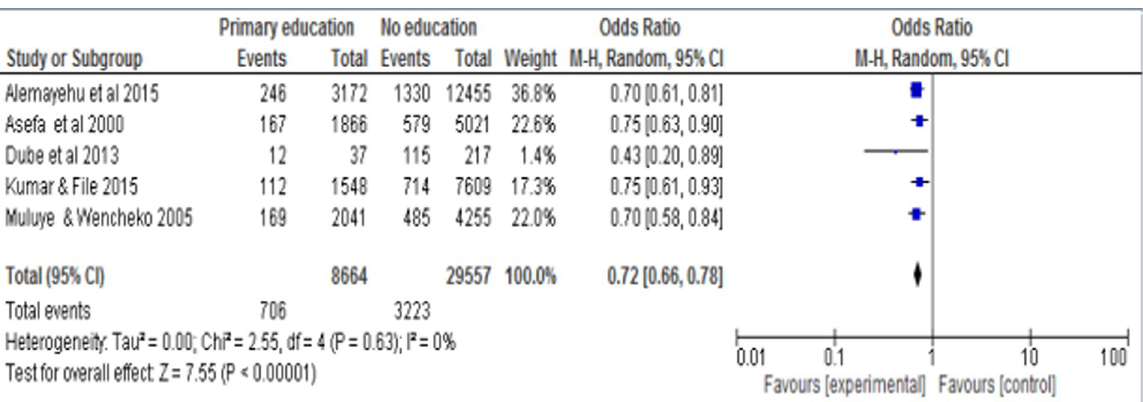
PLOS ONE | https://doi.org/10.1371/journal.pone.0220076 July 29,